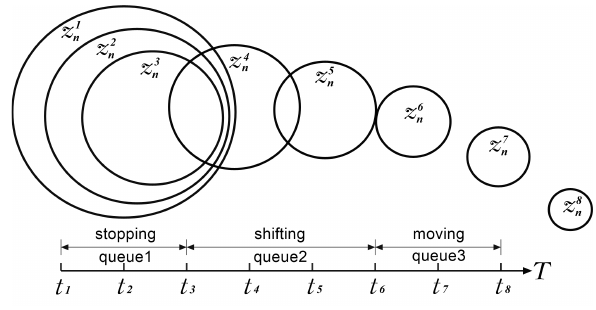
Figure 4. A UHI are continuously stopping , shifting , and moving in three consecutive queues from t 1 to t 8 .